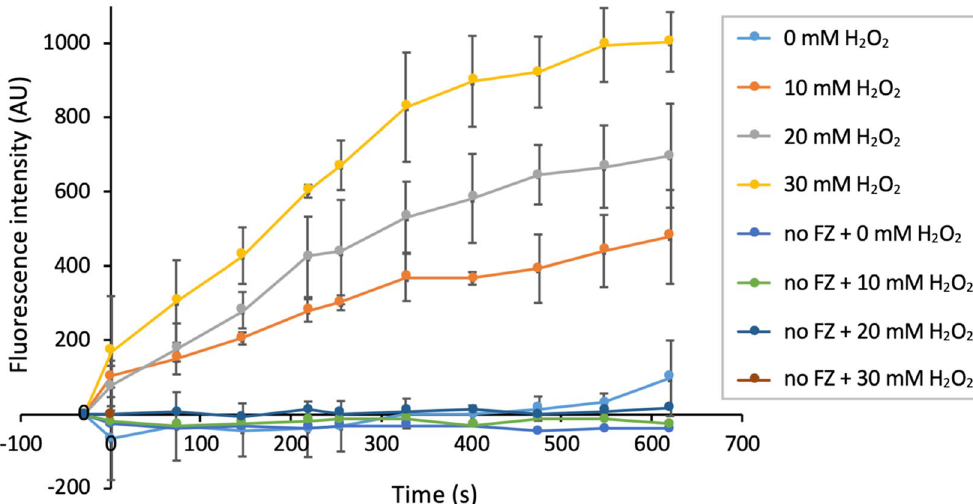
Figure 4. Detection of free intracellular zinc in D. deserti after H 2 O 2 exposure. After de-esterification of FluoZin-3 AM in the cells, increase of free intracellular zinc was measured after addition of H 2 O 2 . The values are corrected for the fluorescence observed after the incubation for 60 min with FluoZin-3 AM but before H 2 O 2 treatment. This observed fluorescence indicates that FluoZin-3 chelates intracellular Zn 2+ already before treatment. Error bars are standard deviation of three independent experiments (biological replicates). no FZ, cells incubated without FluoZin-3